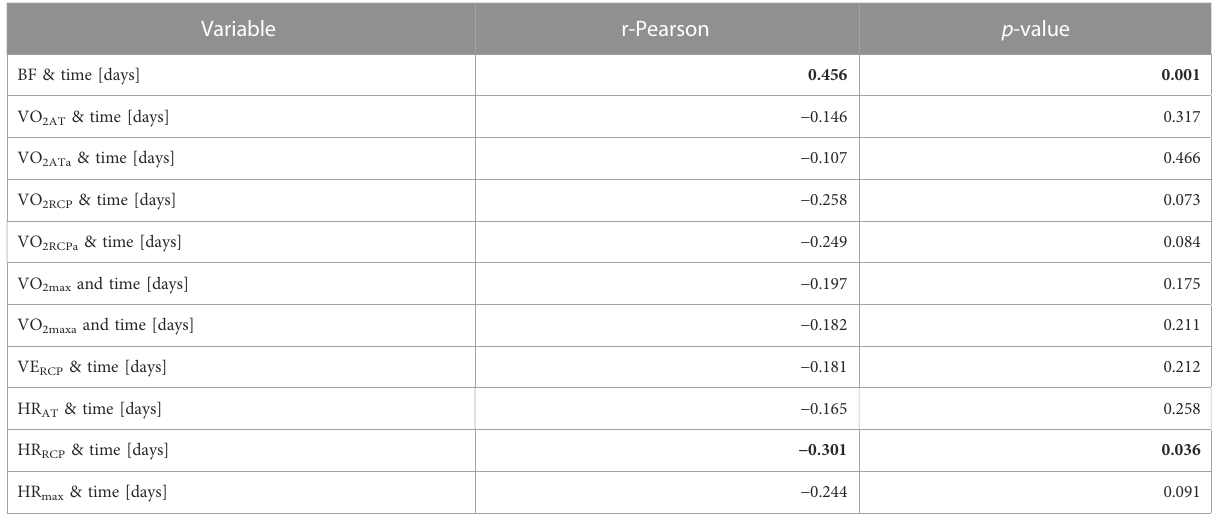
TABLE 5 Pearson ’ s r correlation coef fi cients for CPET and physiologic results adjusted to time.